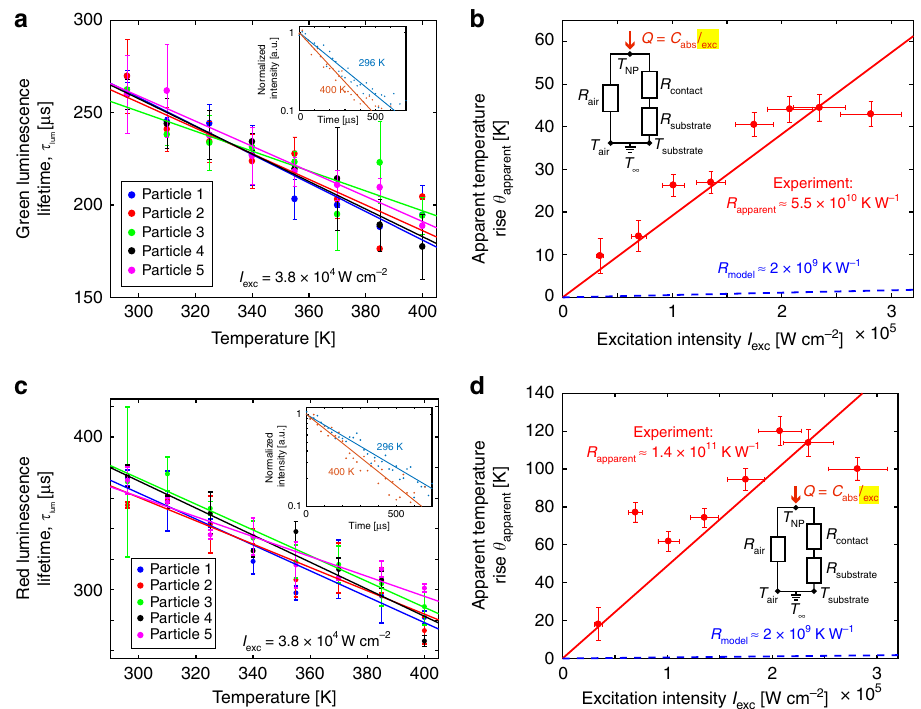
Fig. 3 Luminescence lifetime thermometry and apparent self-heating. a Temperature-dependent luminescence lifetime calibration for the green emission band (540 ± 20 nm) using fi ve individual nanoparticles on a borosilicate glass substrate, along with linear fi ts. The excitation modulation for all measurements was a 50 Hz square wave (50% duty cycle), and the total collection time was 30 s. Error bars in τ lum represent the standard deviation of two consecutive measurements, while error bars in I exc are ±10% to account for decreased laser stability and greater measurement uncertainty at higher I exc . b Apparent temperature rise as a function of excitation intensity measured using the luminescence lifetime of the green spectral band for a single nanoparticle. The substrate temperature was allowed to fl oat such that T substrate = T air = 296 K. The experimentally measured apparent thermal resistance is ~5.5 × 10 10 K W − 1 , in remarkably good agreement with the value of 6.3 × 10 10 K W − 1 obtained from ratiometric measurements, and more than an order of magnitude higher than the conservative model prediction of 2 × 10 9 K W − 1 . Error bars in the apparent temperature rise account for trial-to-trial variation and uncertainty due to the use of a batch calibration curve (see Supplementary Note 5 for details). c , d Similar results for the red emission band (650 ± 20 nm) using the same fi ve nanoparticles. The apparent thermal resistance from the red band is within a factor of 2.5 of that from the green